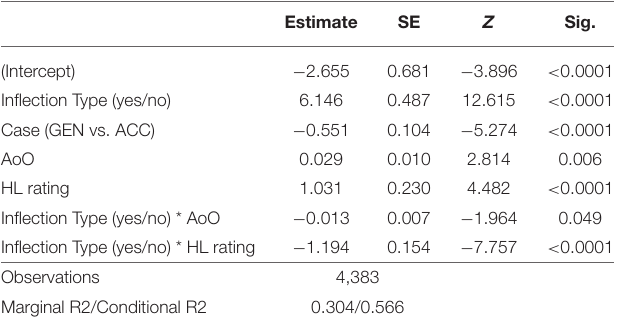
TABLE 6 | Model summary for target case production and language-external factors.